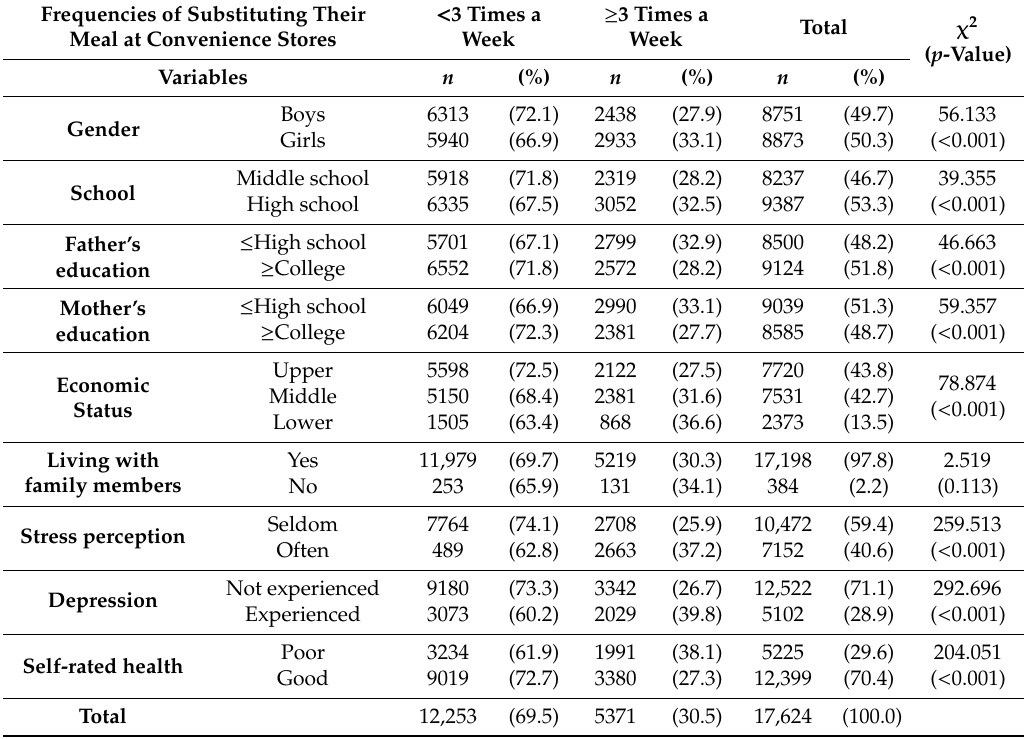
Table 1. Di ff erences in Frequencies of Substituting Meals for Convenience Store Food According to Socio-Demographic Characteristics and Health Status of the Study Population.